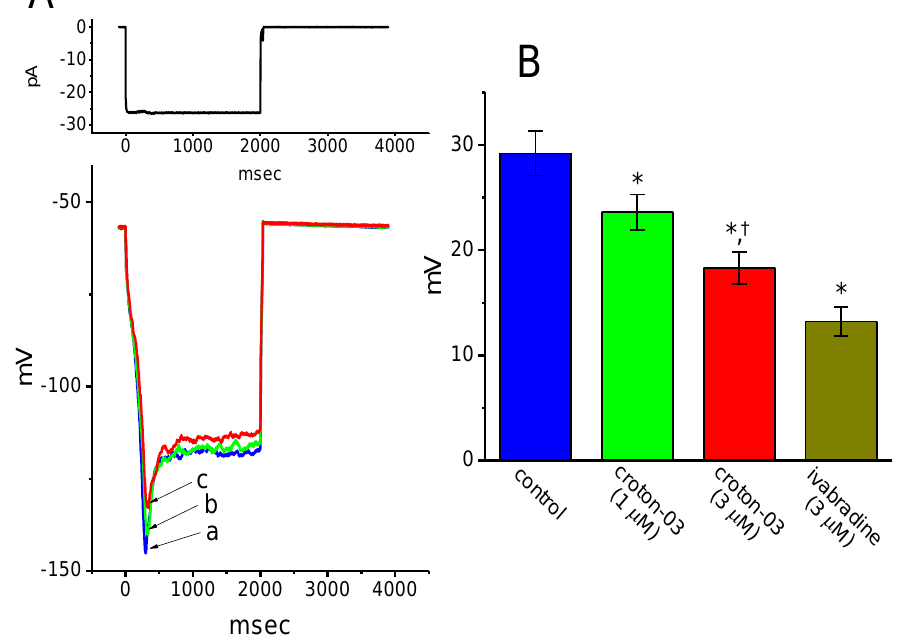
Figure 6. Effect of croton-03 on sag potential identified in GH 3 cells. Cells were bathed normal Tyrode’ solution containing 1.8 mM CaCl 2 and 1 μM tetrodotoxin. Current-clamp voltage recordings were made in these experiments and a long-step hyperpolarizing (i.e., inward) current stimulus was applied to the examined cell. ( A ) Superimposed potential traces obtained in the control (a) and during cell exposure to 1 μM croton-03 (b) or 3 μM croton-03 (c). Upper part indicates the long-step current injection applied. ( B ) Summary bar graph showing the effect of croton-03 or ivabradine on the amplitude of sag potential (mean ± SEM; n = 6–8 for each bar). The amplitude of sag potential (i.e., difference between the beginning and end of hyperpolarizing stimulus) was taken in the absence and presence of croton-03 or ivabradine. * Significantly different from control ( p < 0.05) and † significantly different from croton-03 (1 μM) along group ( p < 0.05).